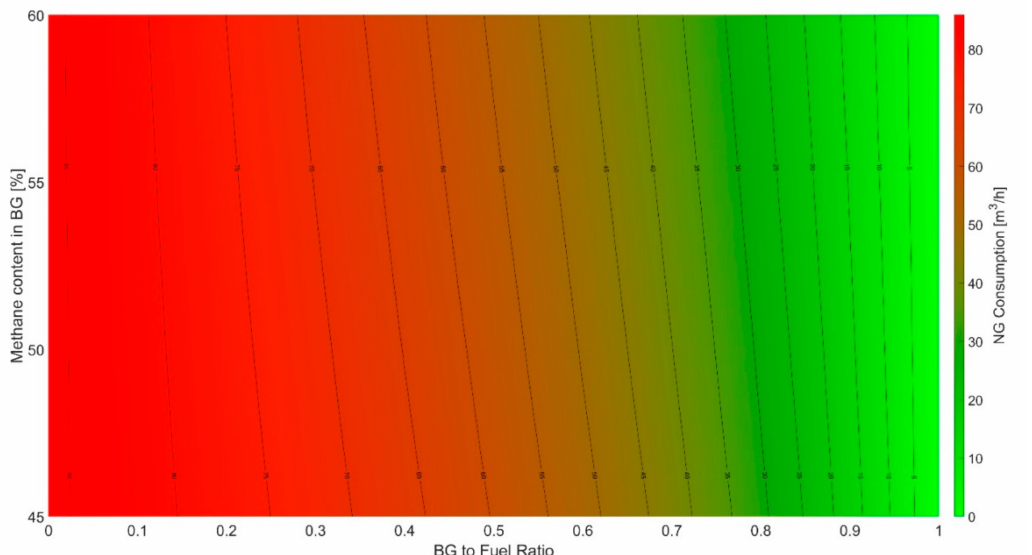
Figure 8. Potential natural gas savings represented as natural gas consumption as a function of biogas-to-fuel ratio and methane content in